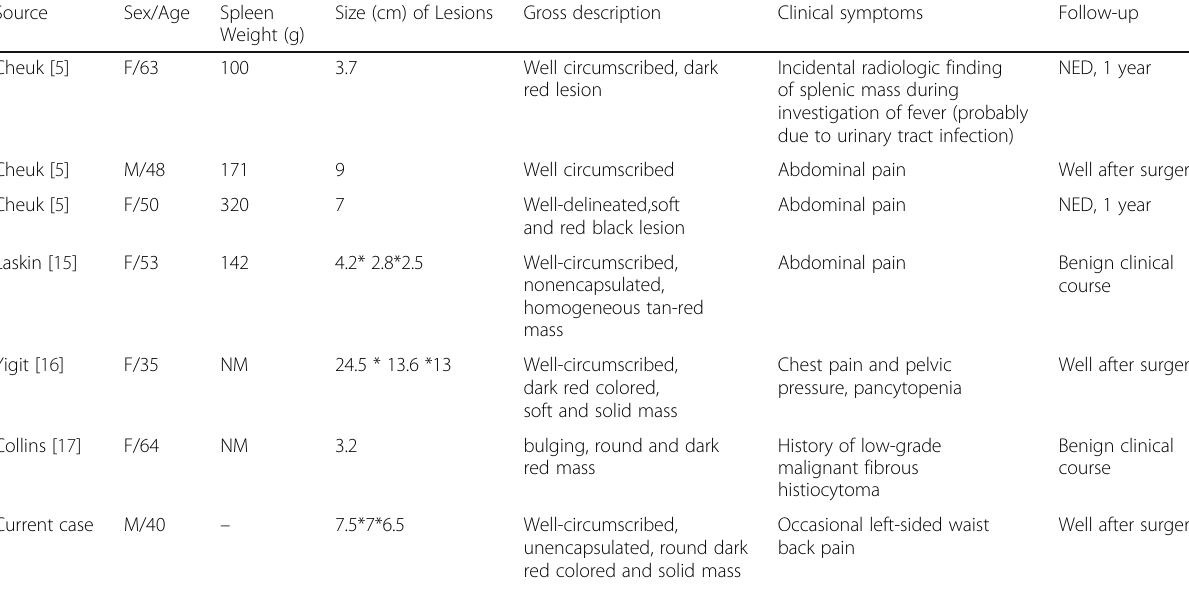
Table 2 Clinicopathologic features of reported cases of splenic hamartomas with bizarre stromal